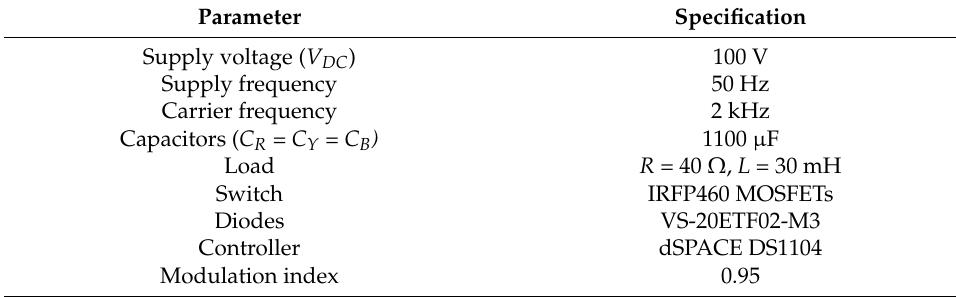
Table 4. Simulation and experimental results: Useful